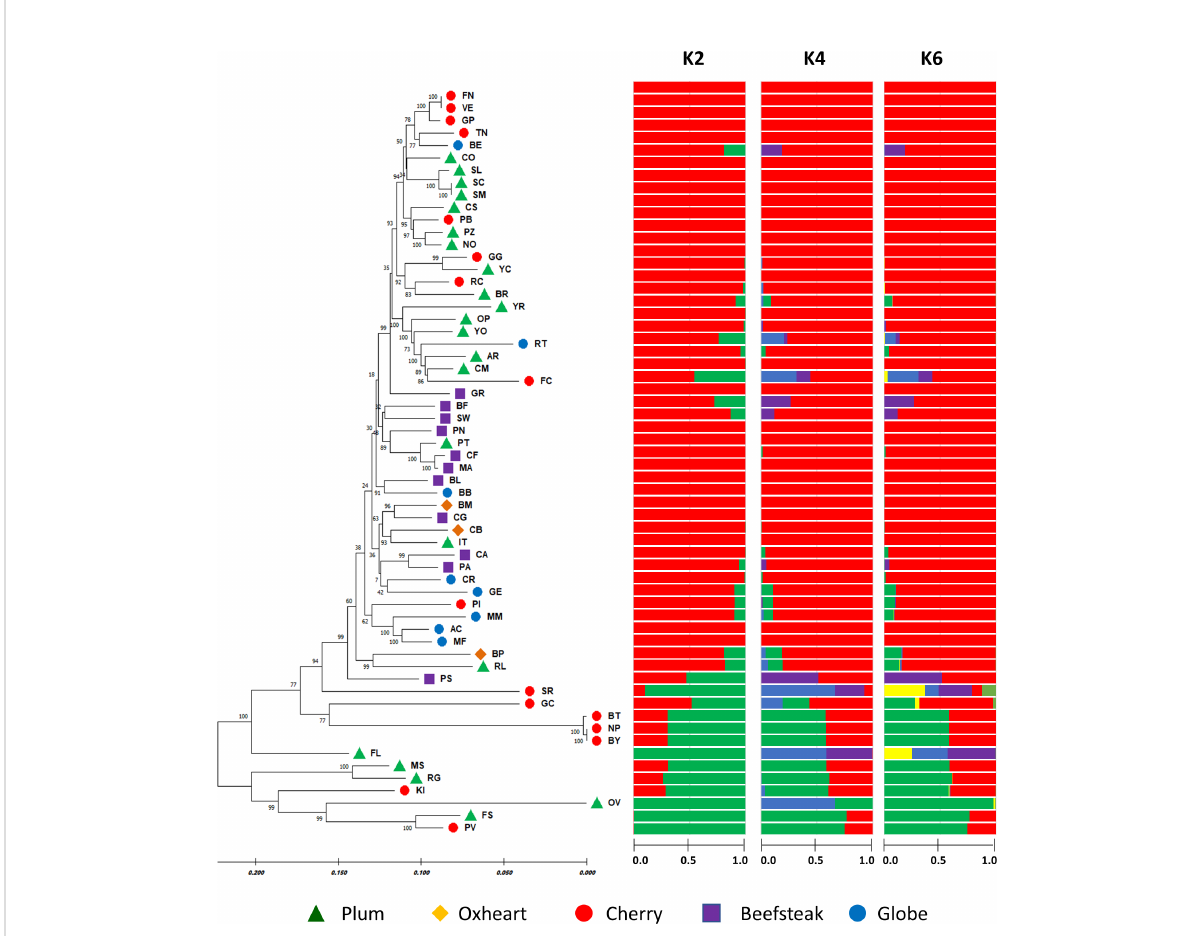
FIGURE 6 Phylogenetic analysis and population structure of 60 tomato accessions based on 7,591 SNPs. On the left, the neighbor-joining phylogenetic tree was computed using the maximum composite likelihood method. Numbers at the nodes are bootstrap values for 1,000 replicates. Accessions of different cultivar groups are represented by different colored symbols as listed in the legend. On the right, STRUCTURE analysis considering the most likely number of subpopulations K = 2 based on Evanno ’ s test. Clustering at K = 4 and K = 6 is shown. Horizontal solid bars for each genotype represent the allele frequency (indicated with numbers) for each K